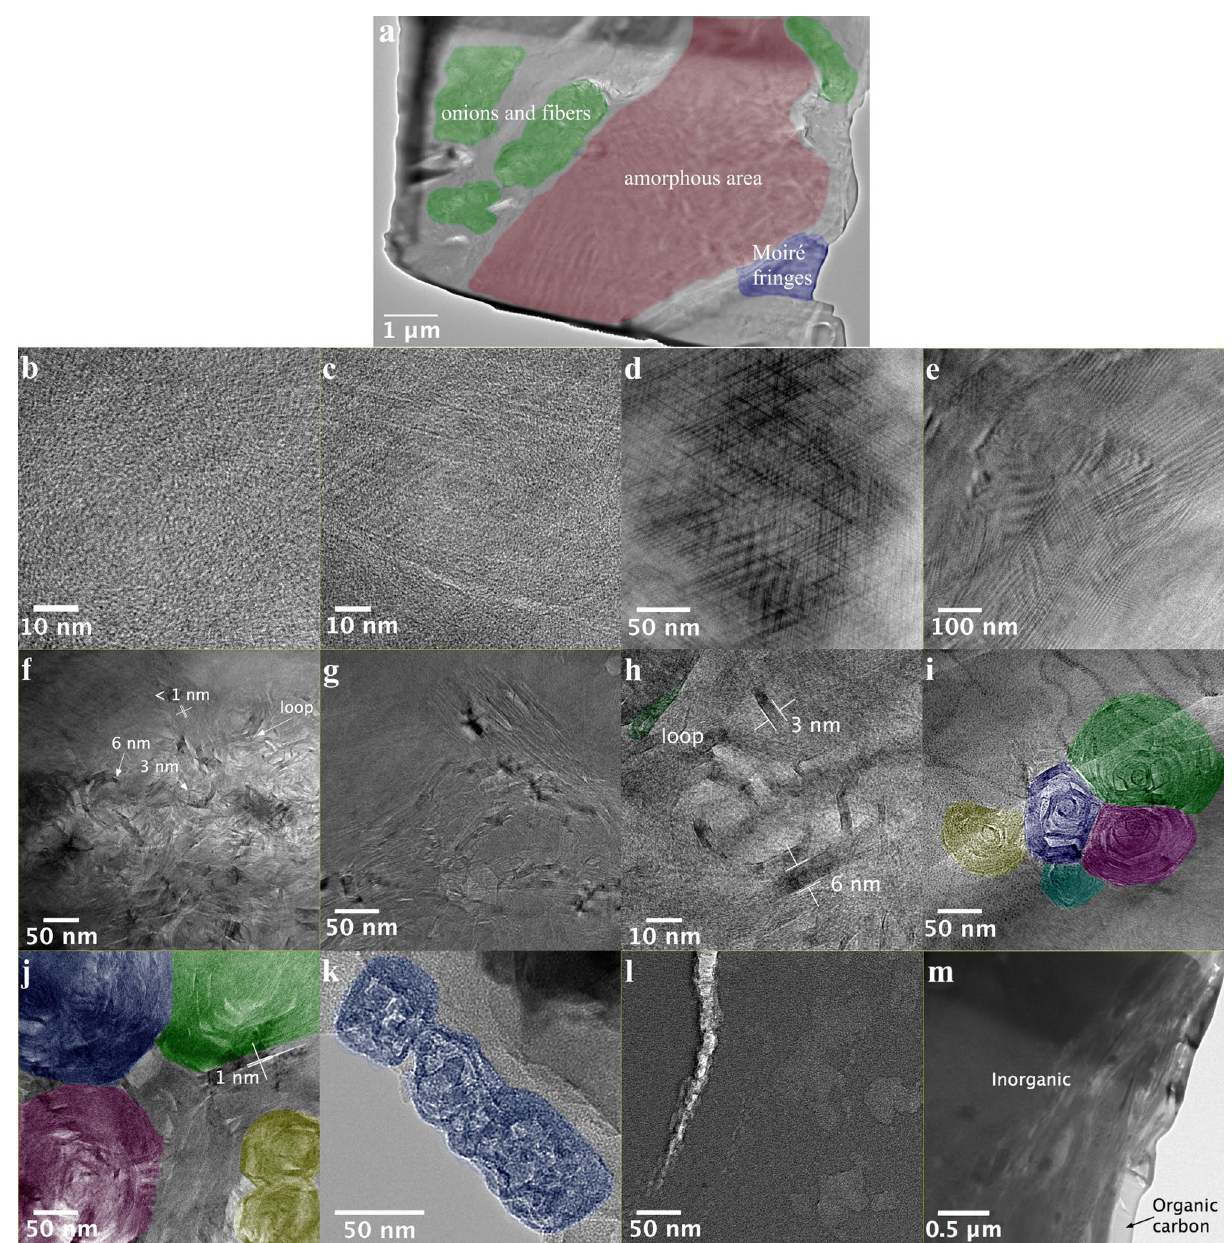
Figure 4. TEM images of ( a ) spatial variability of Marcellus shale lift-out; respectively, Marcellus’ and Barnett’s ( b , c ) amorphous structure, ( d , e ) Moiré fringes, ( f , g ) fibers, ( h ) zoomed-in region of Marcellus’s micrograph in ( f ), ( i , j ) onions, ( k ) kerogen-enriched Marcellus shale bulk particle, ( l ) amorphous structure of Utica’s kerogen and ( m ) Utica’s lift-out. Coloring is for the guidance to the